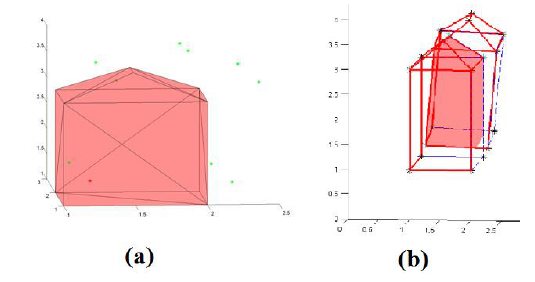
Figure 3: Calculation of convex hull(a) and intersection volume (b).